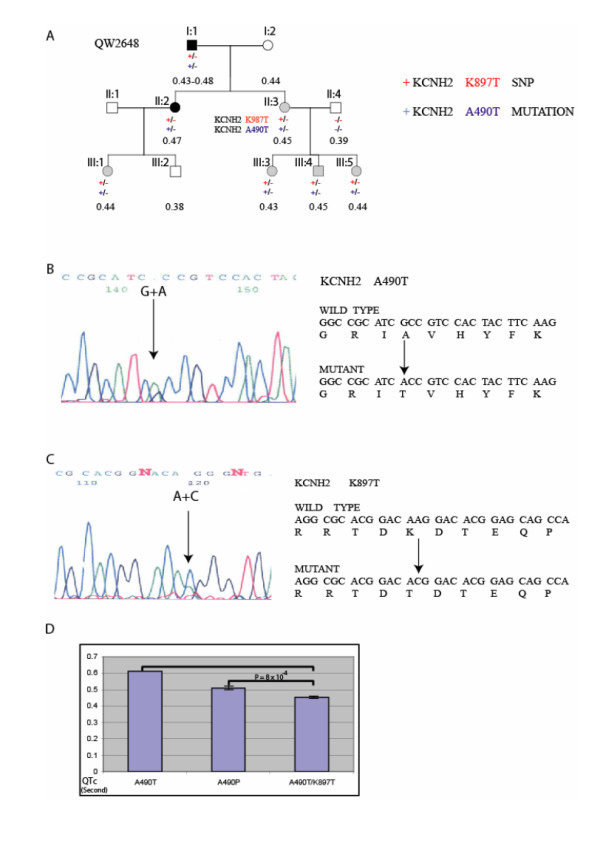
Identification and co-segregation of KCNH2 mutation A490T and SNP K897T in family QW2648 and with LQTS. (A). Pedigree structure of family QW2648. All the affected individuals carry double variants, K897T and A490T of KCNH2 on the same chromosome (in cis orientation). (B, C). DNA sequence analysis for the proband in family QW2648. A heterozygous G→A transition at nucleotide 1468 of KCNH2, which results in a substitution of alanine by threonine (A490T) (B). DNA sequence for KCNH2 SNP K897T is shown in (C). (D) Comparison of mean QTc for carriers with KCNH2 mutation A490T, A490P, and both A490T and SNP K897T.